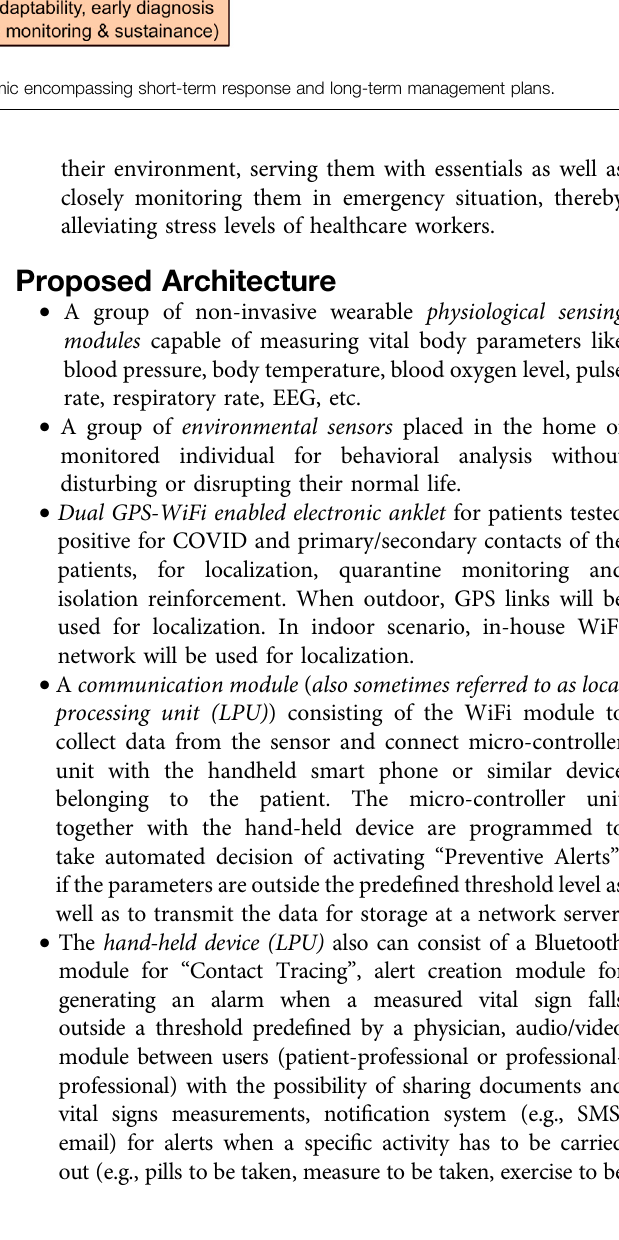
Frontiers in Communications and Networks |